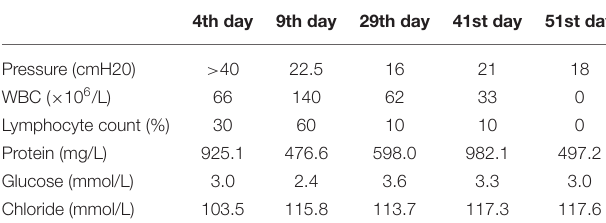
TABLE 1 | Results of serial cerebrospinal fluid